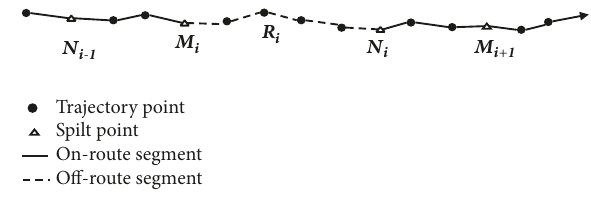
Figure 2: Trajectory data splitting.